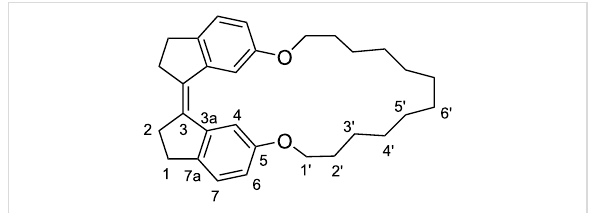
Figure 9: Numbering of carbons in compounds ( Z )- 1a – d , showing ( Z )- 1d as an